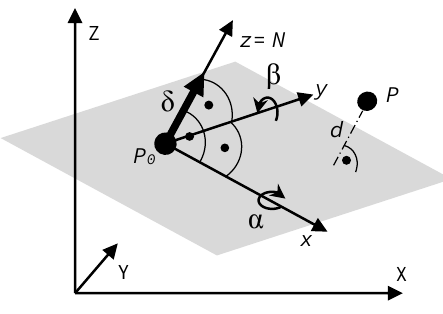
Figure 2: Local plane parameterisation with two angles α, β and a shift δ (bold arrow) along the local z -axis, which is the plane normal N . d : distance of a point P from the